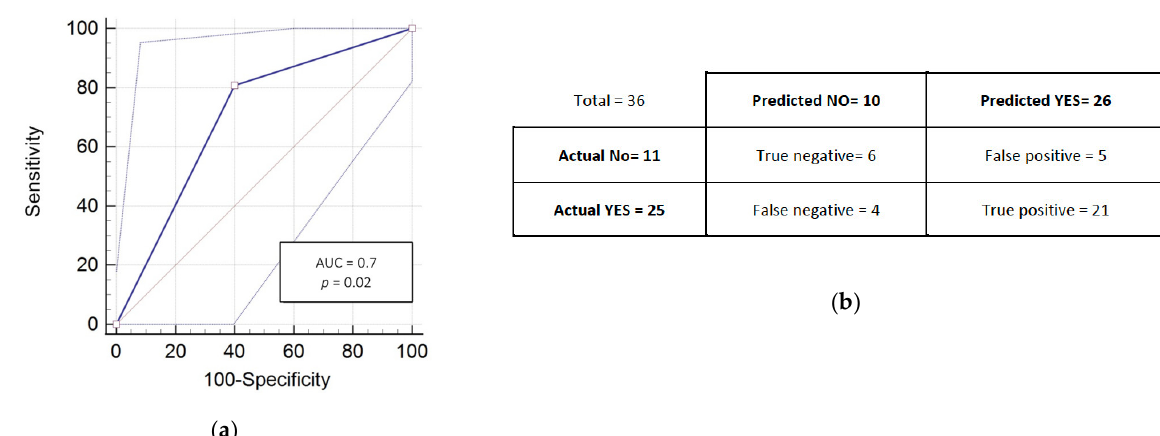
Figure 2. Prediction results and performances of the RadioDtect ® assay of the 36 HNSCC patients. ( a ) ROC analysis was performed on pATM ELISA results and a Wilcoxon rank sum test was also applied to compare RR and RS groups ( p = 0.02). ( b ) Confusion matrix results for the prediction from the pATM